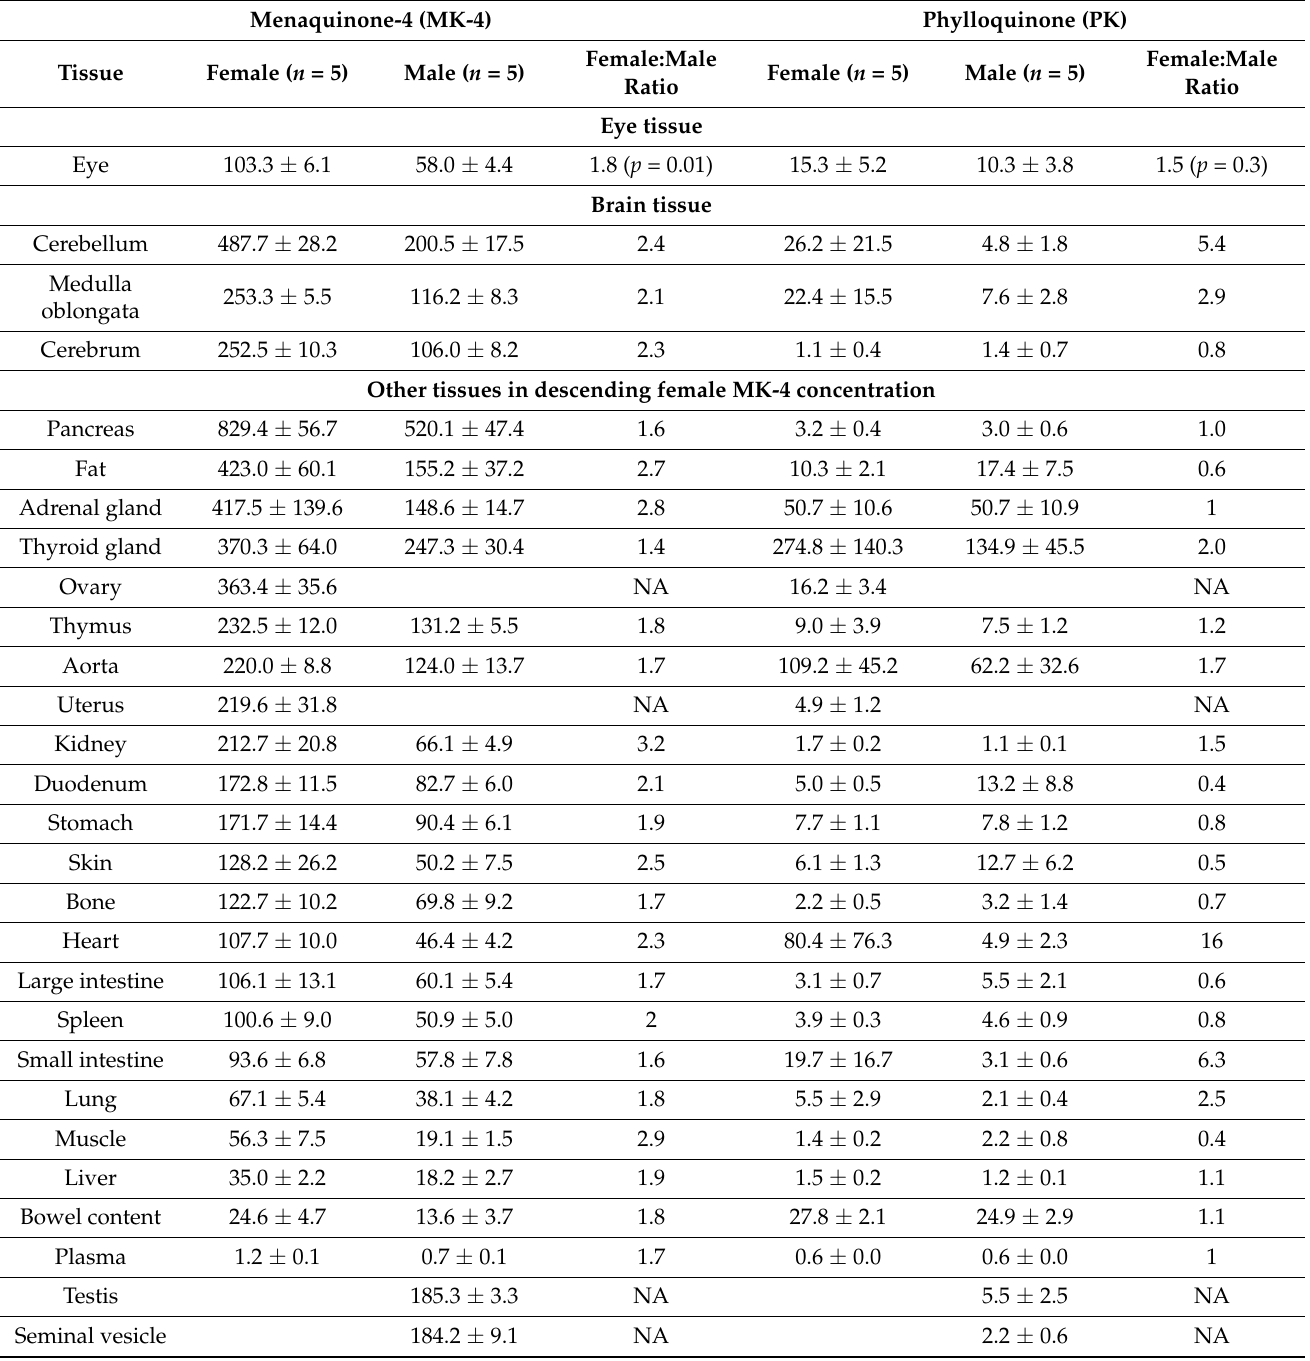
Table 2. Tissue distribution of VK in mice fed a normal diet. Values are presented as means ± S.E. ( n = 5) in pmol/g tissue or pmol/mL plasma in female and male mice. p values represent results of Mann–Whitney U test comparison between female and male eye MK4 and PK